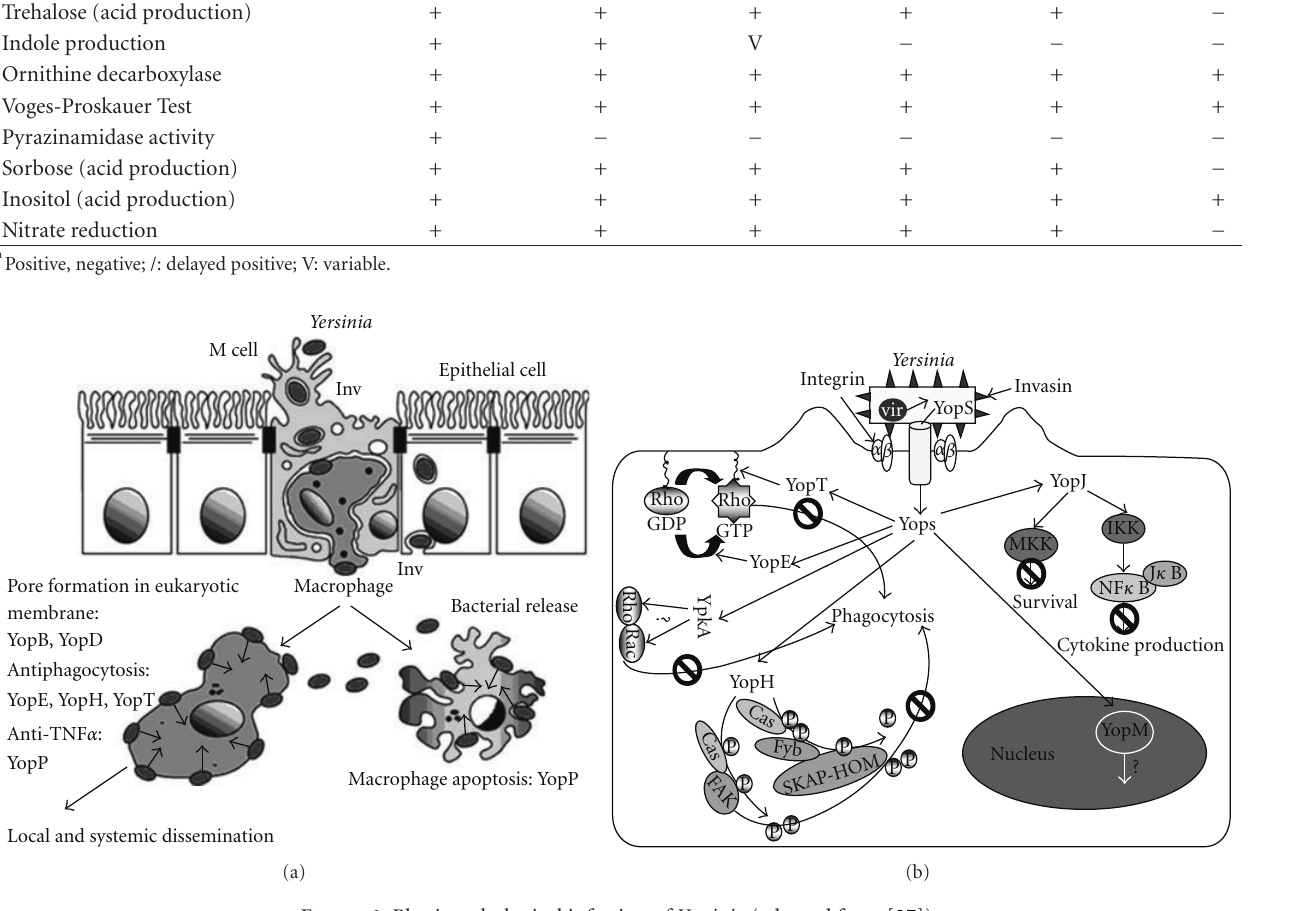
Figure 1: Physiopathological infection of Yersinia (adopted from